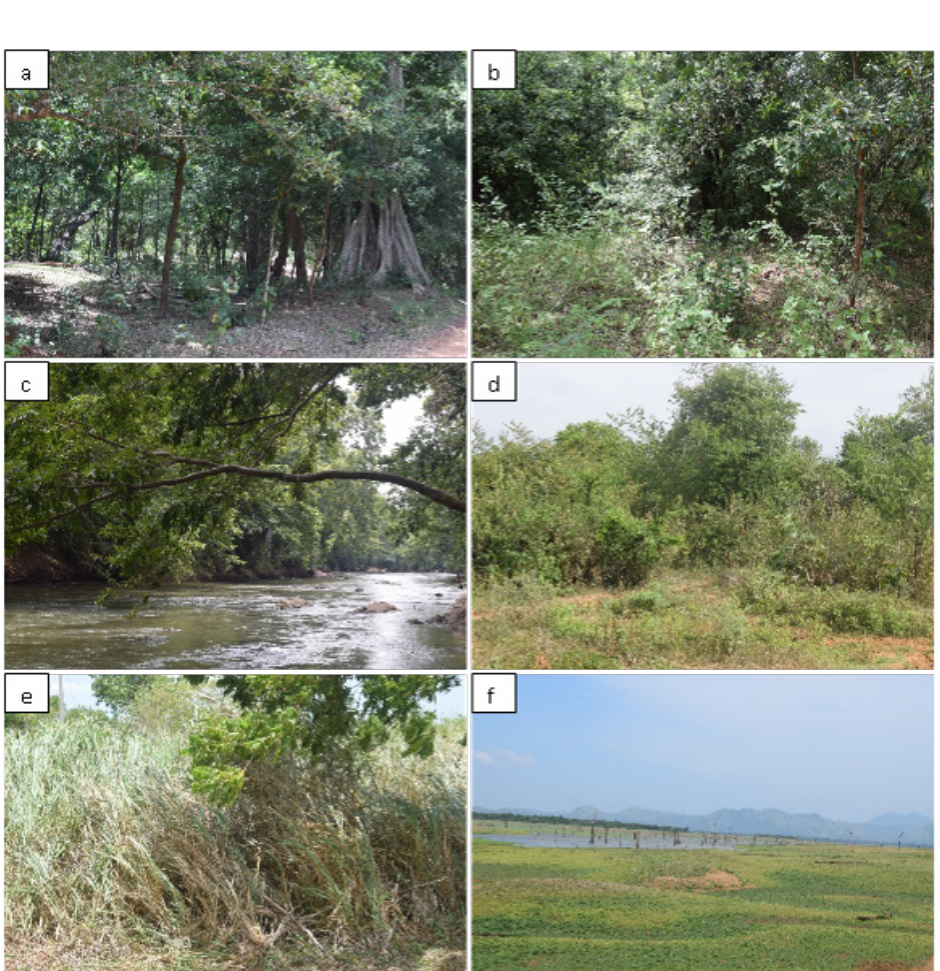
Figure 2: The three habitat types considered in the study (photographed by K.T. Krishan in September 2020): (a) Undisturbed forest (b) Disturbed forest (c) Riverine forest (d) Scrub (e) Panicum dominated grassland (f) Grassland around